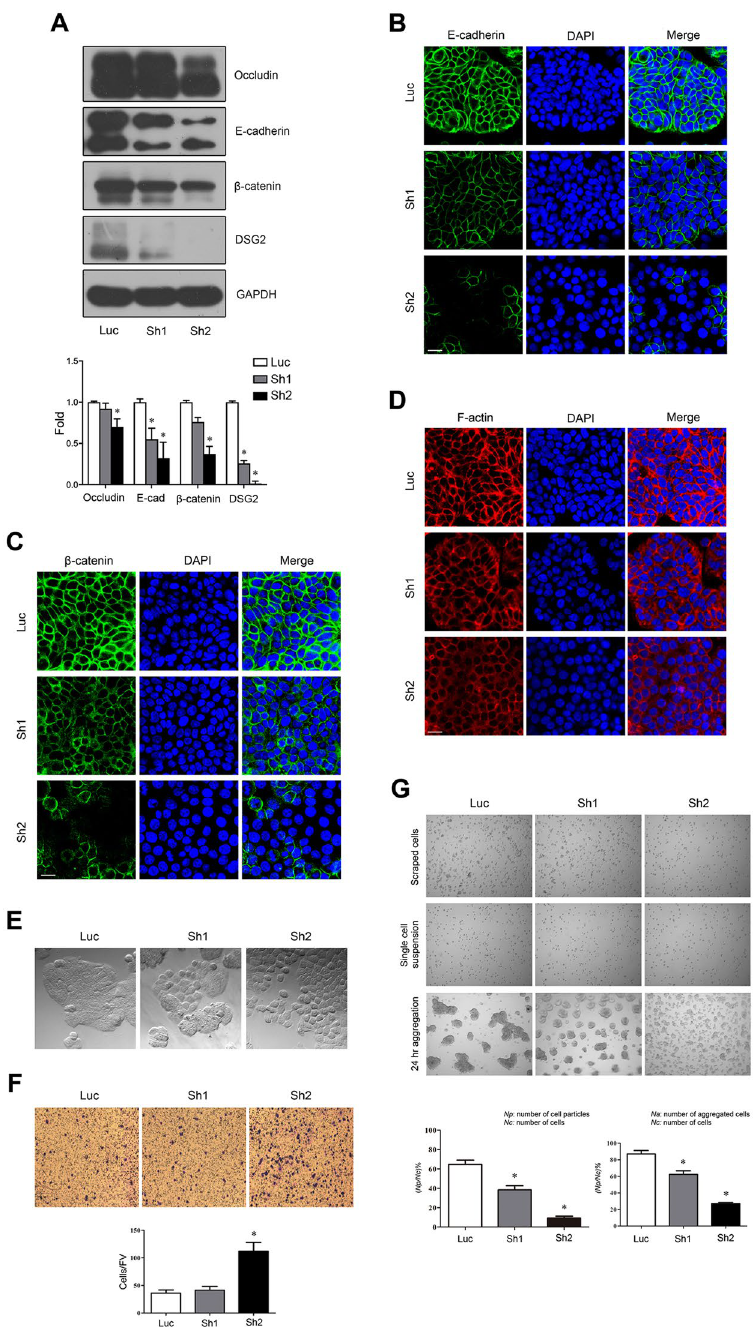
Figure 6. Epithelial junctional complexes affected by symplekin depletion. ( A ) WB bands and quantification analysis for expressions of occludin, E-cadherin, β -catenin, and DSG2 in stable symplekin-silenced HT-29 cells (Sh1 and Sh2) and the control (Luc). ( B , C ) IF staining of E-cadherin and β -catenin in the above stable clones. DAPI showed the nuclei staining. ( D ) Cytoskeletal F-actin staining using rhodamine phalloidin. ( E ) Morphological comparison among indicated HT-29 cell colonies captured by a phase-contrast microscopy. ( F ) Matrigel invasion assays in HT-29 cells with or without symplekin knockdown. The migrated cells were stained with crystal violet and counted in six random fields. FV, field vision. ( G ) Cell disassociation and aggregation analyses. Six random fields were chosen for each group. * P < 0.05, one-way ANOVA and Student’s t-test. All results are means ± SD, n = 3. Bars, 20 μ